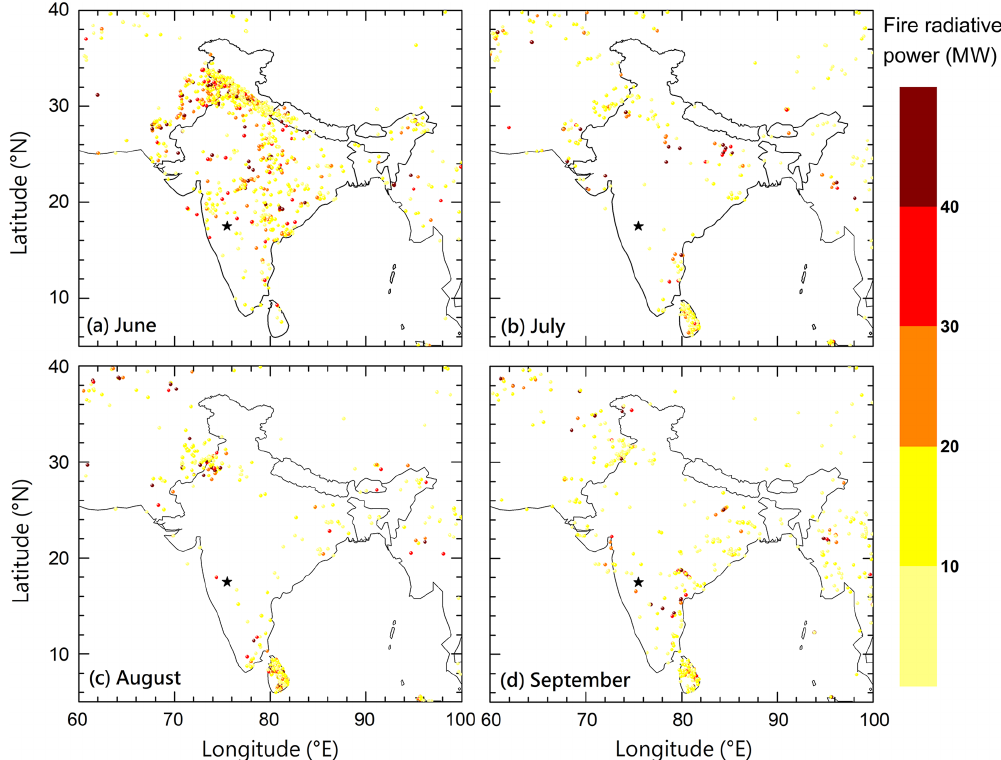
Figure A1. Spatial distribution of the Moderate Resolution Imaging Spectroradiometer (MODIS) fire radiative power (Collection 6 product obtained from https://earthdata.nasa.gov/firms, last access: 23 July 2019) for the measurement periods, along with the observation site marked as a black star. Data points having confidence values higher than 30, which come under the classification of “nominal” and “high”, are only